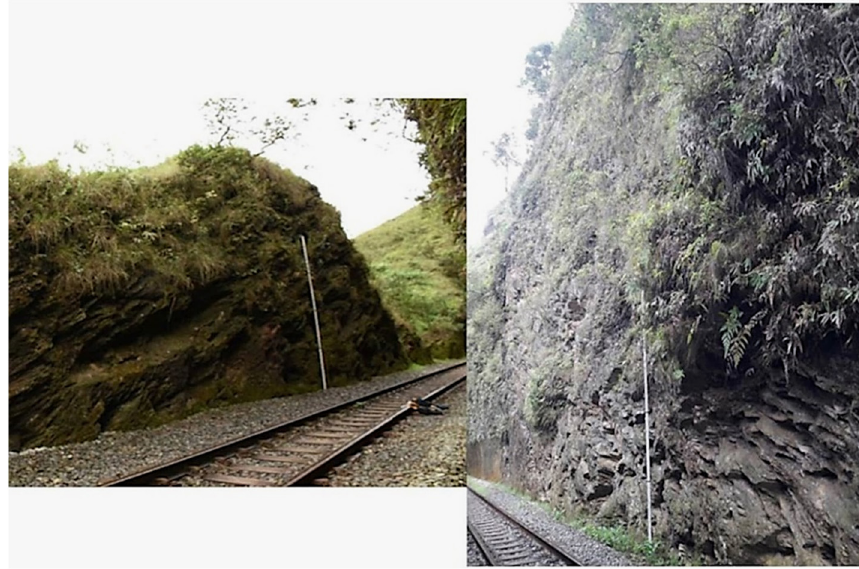
Figure 5. Railway showing sides A and B of Slope ‐ 2.